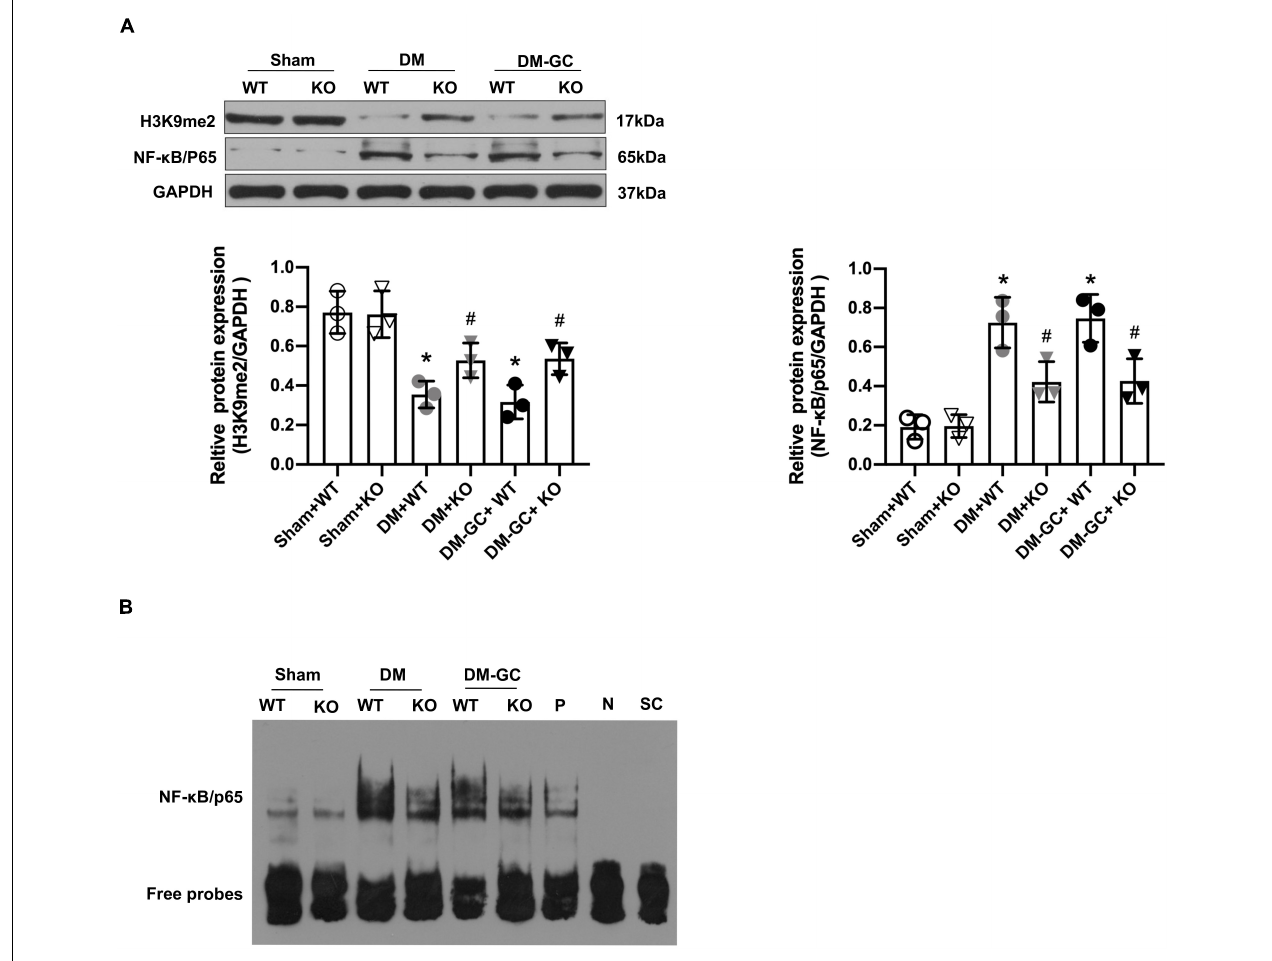
FIGURE 6 | KDM3A regulates the expression and DNA binding ability of NF- κ B/P65 in diabetic myocardium. (A) To explore whether KDM3A participates in regulating NF- κ B/P65 under diabetic conditions, the proteins of P65 and H3K9me2 were detected by western blot ( n = 3). (B) The DNA binding ability of NF- κ B was assessed by the EMSA method. * p < 0.05, as compared to the Sham + WT or the Sham + KO group; # p < 0.05, as compared to the DM + WT or the DM–GC + WT